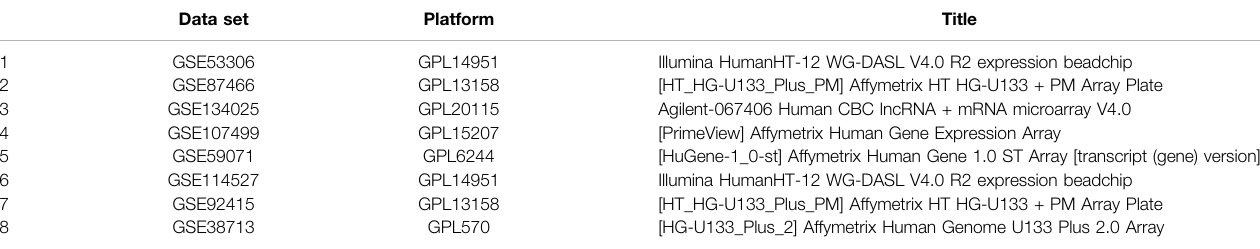
TABLE1 | The platform information corresponding to all data sets in the present study. Data set